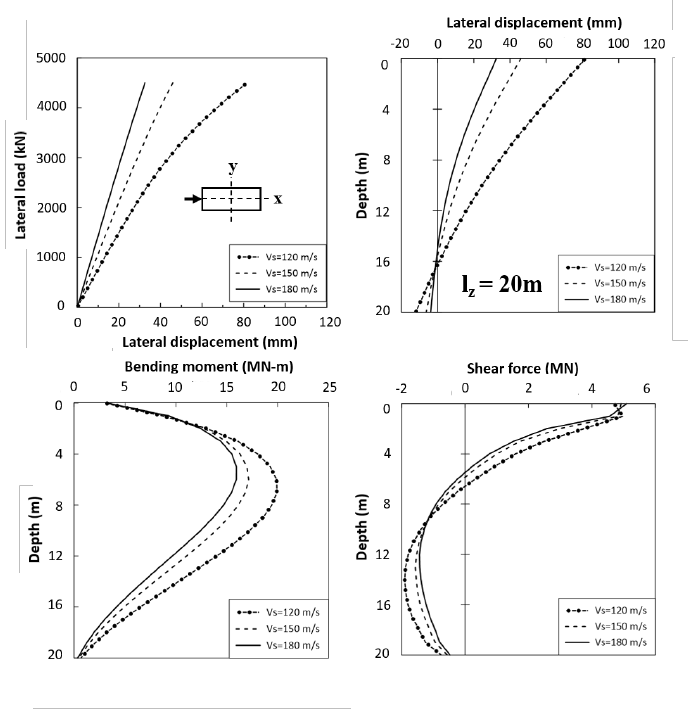
Fig. 10. Performance of 20m barrette in clays with load applied in longitudinal